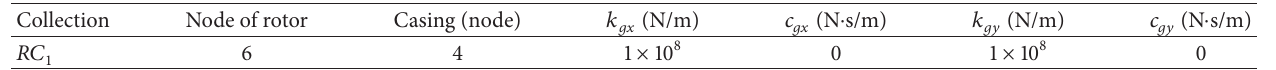
Table 6: Spring collection parameters of rotor-casing.